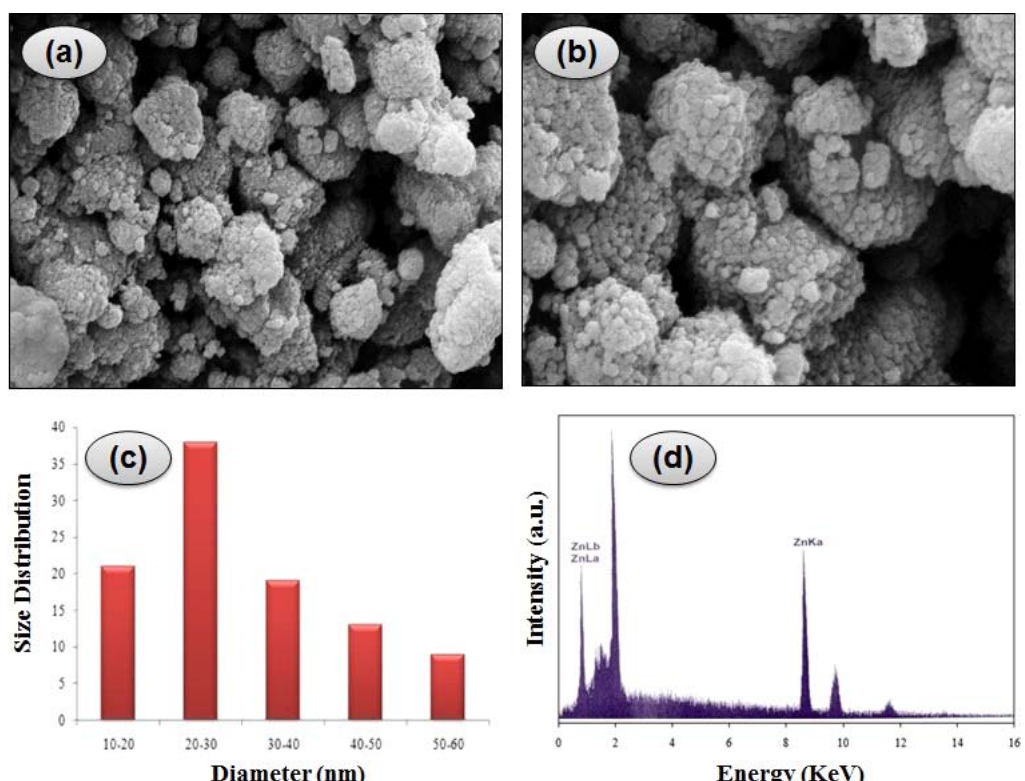
Fig. 8. (a,b) SEM photographs, (c) particle size distribution histogram, and (d) EDAX analysis of ZnO nanoparticles pre- pared by thermal decomposition of compound 1 at 600